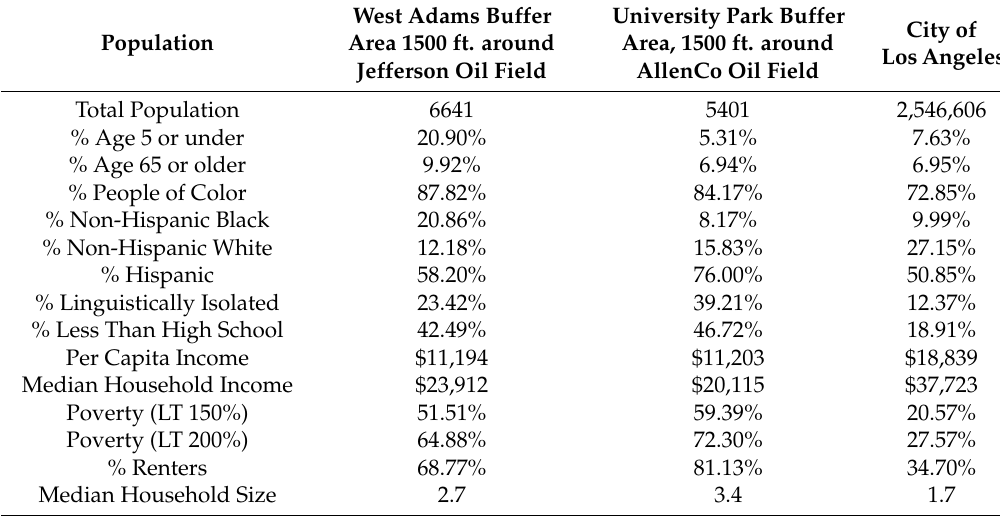
Table 2. Demographics of West Adams and University Park within the 1500 ft.